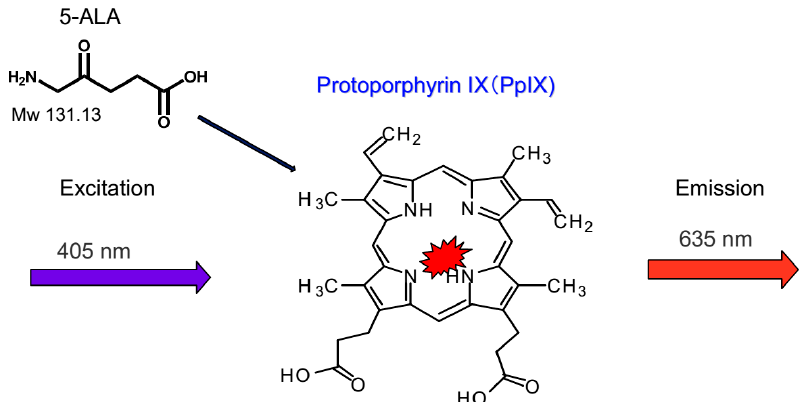
Figure 3. Molecular structure of 5-ALA, and 5-ALA-based PDD. Following excitation with blue light ( λ = 400–410 nm), the PpIX emits a red-violet light of 635 nm. This phenomenon is potentially exploitable to detect tumor and is named 5-ALA fluorescence-guided surgery.